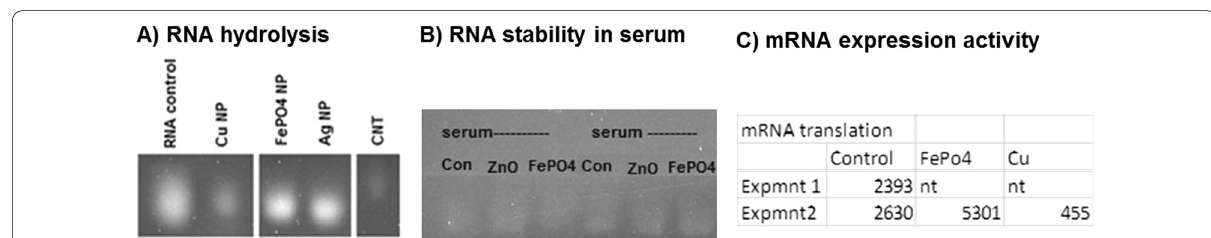
Fig. 5 RNA hydrolysis. a A model RNA we have used in a number of our publications similar in size and sequence composition to most mRNAs from torula yeast (TY-RNA) was used. The RNA was incubated in double-distilled water over time in the presence or absence of nanoparticles either copper (Cu NP), iron phosphate (FePO4), silver (Ag NP) or carbon nanotube (CNT) at 37 degrees celcius and samples removed at the same time point and assayed by RNA agarose gel electrophoresis (RAGE). Loss of band staining intensity indicates RNA degradation whereas maintenance of RNA band staining intensity indicates stabilization. b Similar to above, RNA was incubated in 10% FBS/DMEM at room temperature in the presence of zinc oxide (ZnO) NP or FePO 4 NP versus control which was RNA alone in the absence of nanoparticle. Again samples were removed over time and assayed by RAGE, presence of the stained RNA band over time again indicates stability and resistance from nuclease or RNase degradation from the serum. c mRNA encoding Luciferase was translated in vitro from standard rabbit reticulocyte and the relative luminescence standardized to RNA in the presence or absence of either iron phosphate (FePO 4 ) or copper (Cu)